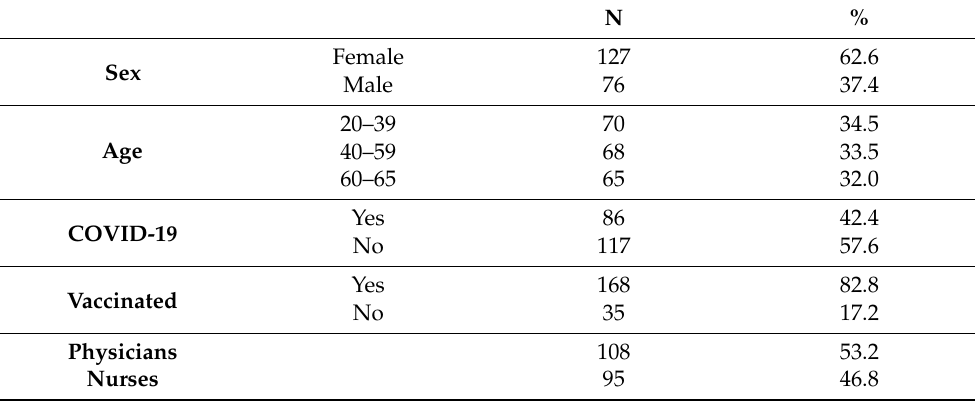
Table 1. Characteristics of the study